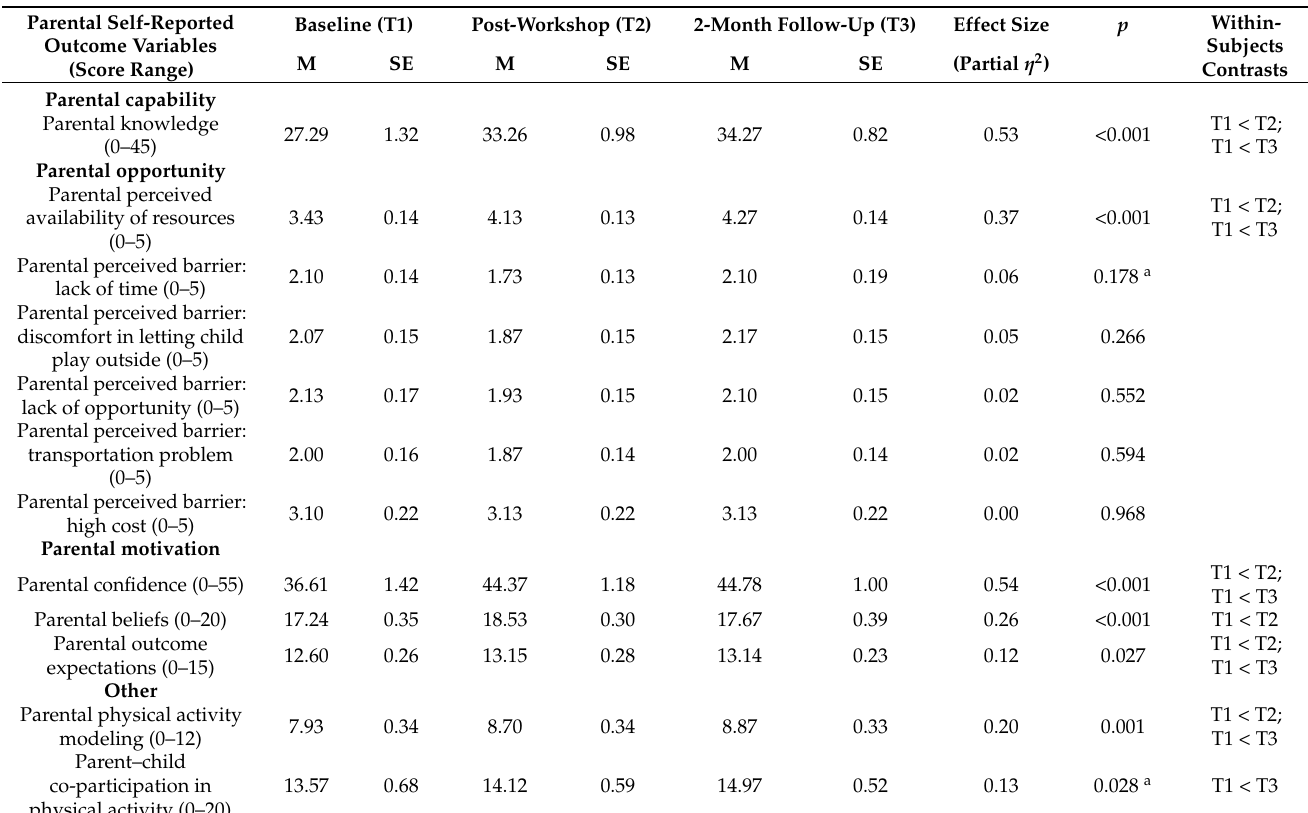
Table 5. Results from repeated measures ANOVAs for the mean changes in parental capability, activity between baseline, post-workshop, and 2-month follow-up (n =